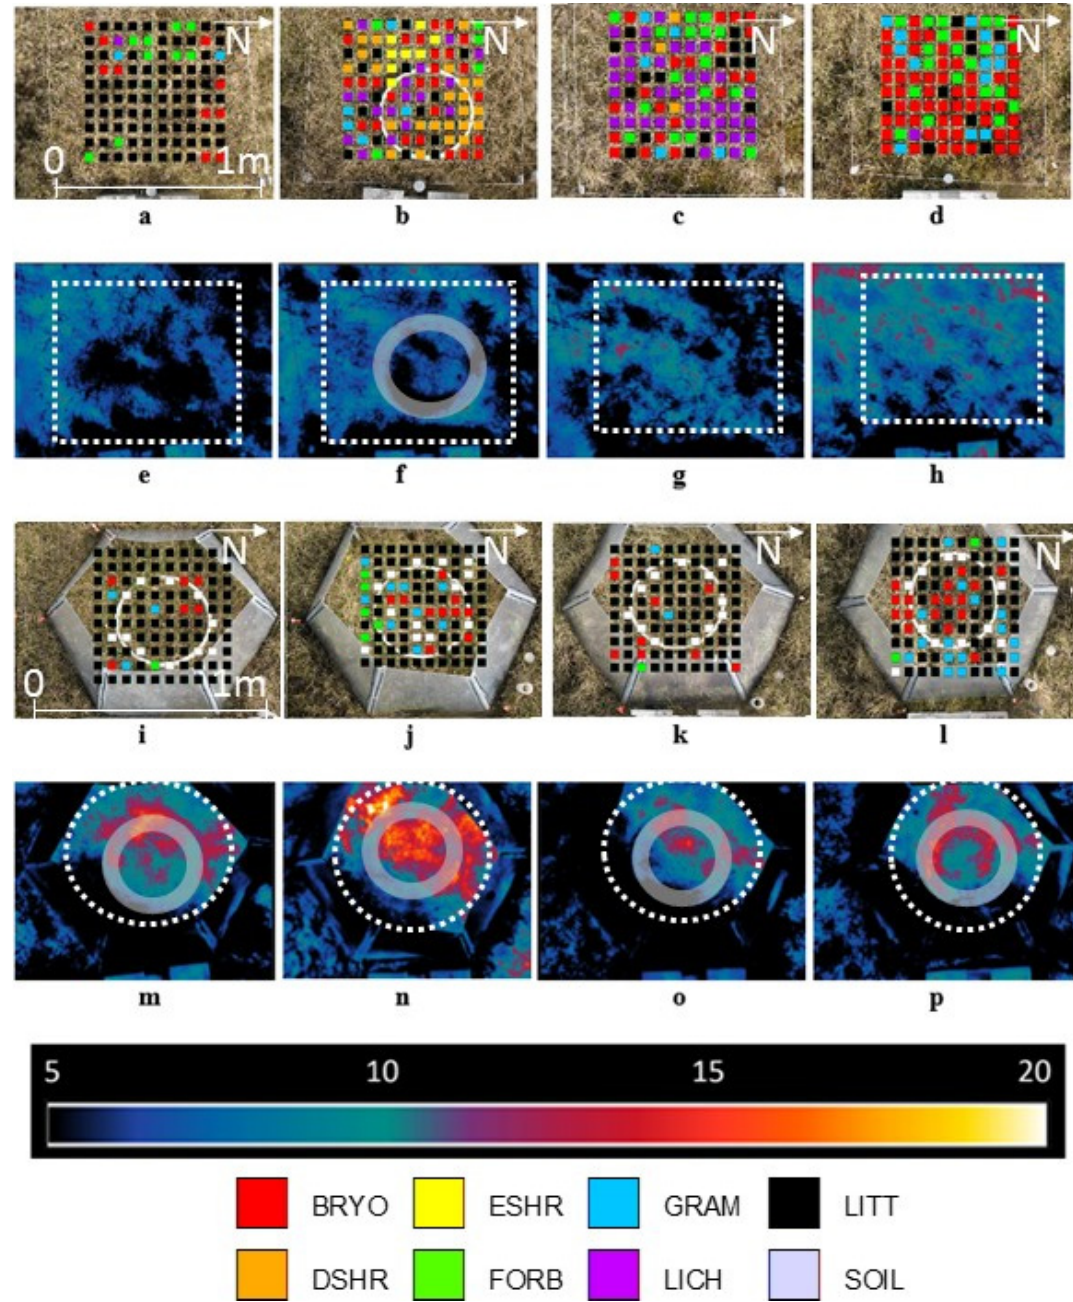
Figure 4. Images depicting four Barrow wet site plots ( a – d ) and the coinciding thermal images below ( e – h ); and images of four additional plots ( i – l ) with coinciding thermal images below ( m – p ). Note: the rings appearing in panels ( b , f , i – p ) are gas exchange collars not related to this study. Areas of image analysis are outlined with dotted white lines. Data in the transparent circular areas have been removed. All temperatures are in degrees Celsius. Plant growth forms and surface features are depicted with the following abbreviations—BRYO: bryophyte/moss; DSHR: deciduous shrub; ESHR: evergreen shrub; FORB: forb; GRAM: graminoid; LICH: lichen; LITT: leaf litter; SOIL: bare soil/rock. White grids symbolize chamber base points or plant identification tags.